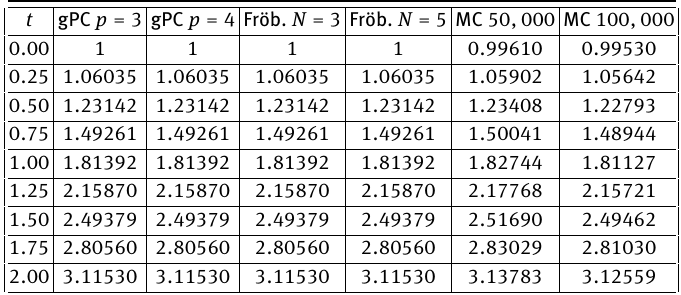
Table 2: Approximation of V [ X ( t )] . Example 4.1, assuming independent random data.